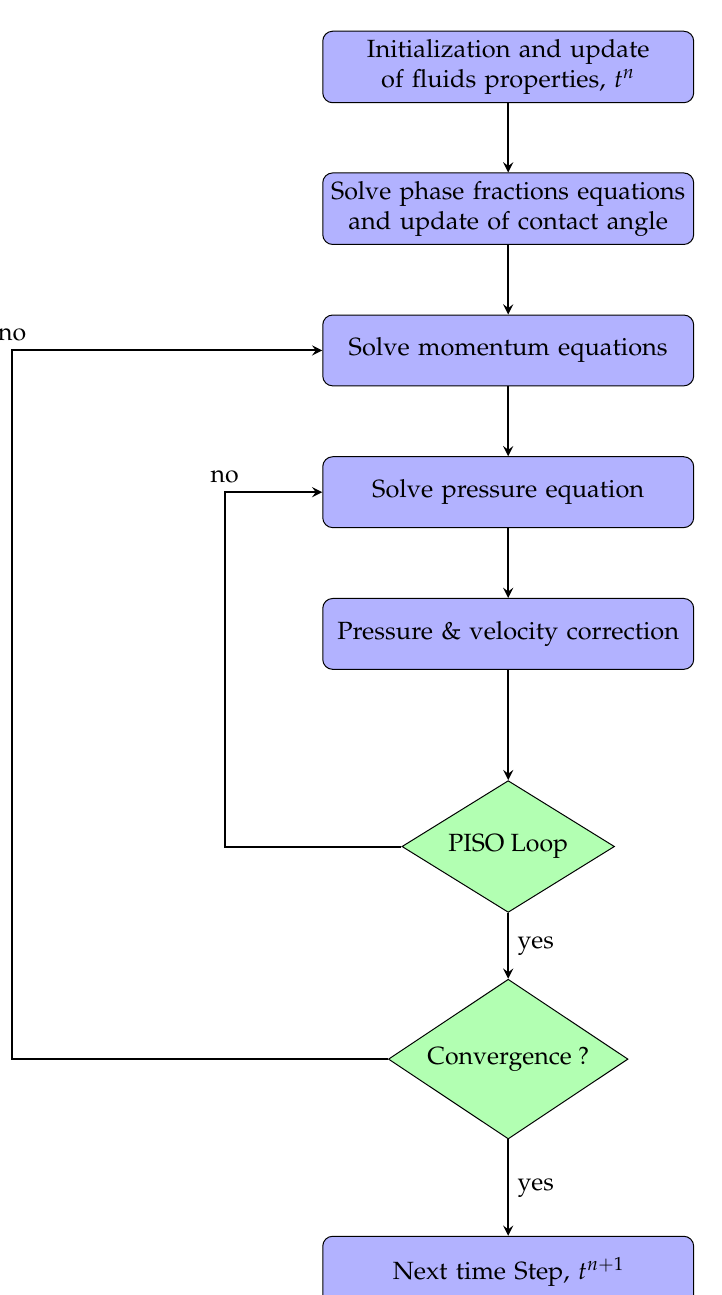
Figure 2. Numerical algorithm for solving the governing equations using the volume of fluid (VOF)